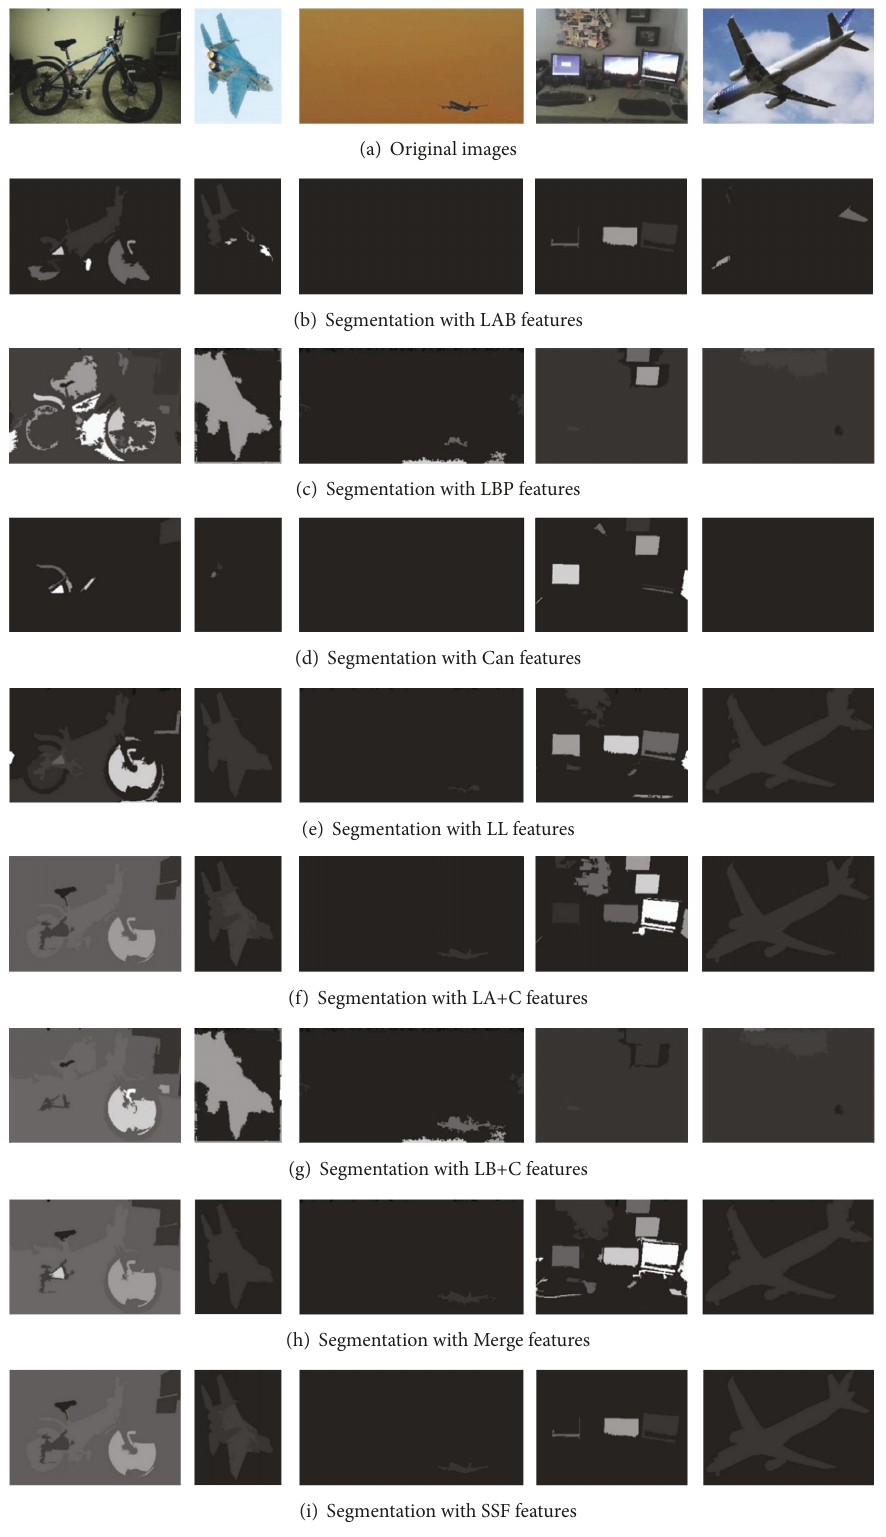
Figure 3: Graphical results of five example images segmented by different features. Right to left: No. 002227, No. 002619, No. 005043, No. 005902, and No.